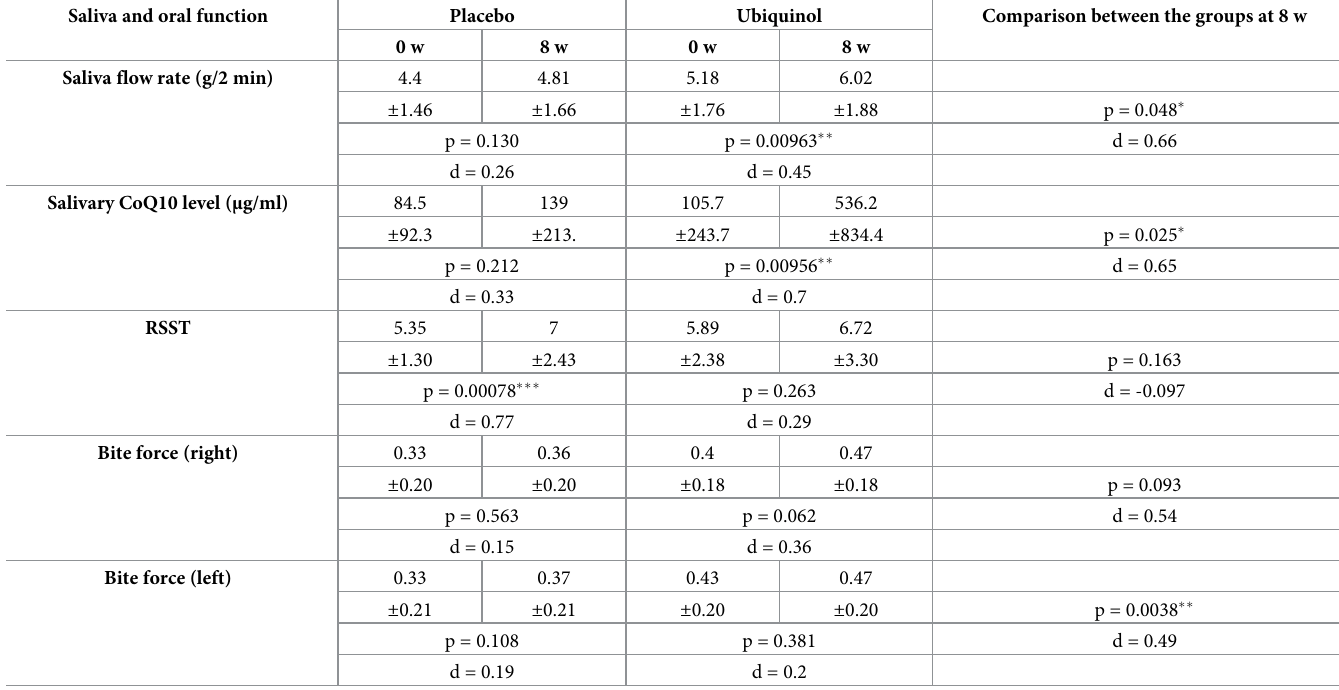
Table 3. Comparison of parameters between before and after the treatment period.